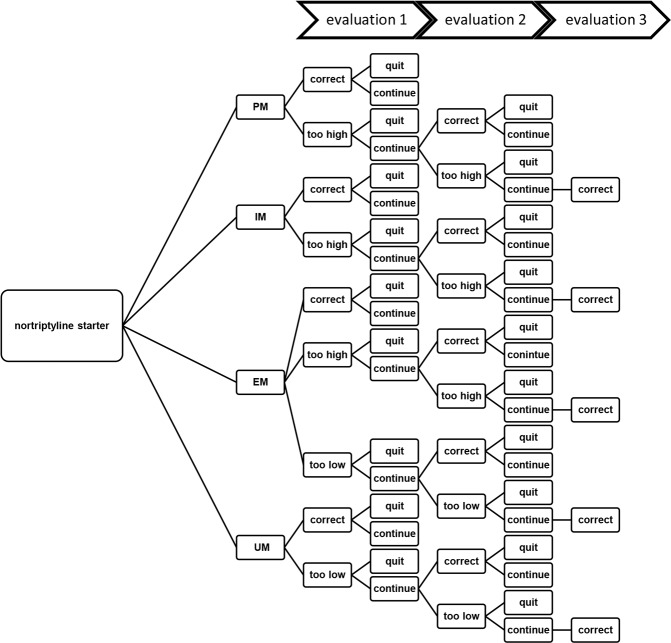
Model structure for the treatment of major depressive disorder with nortriptyline during the first 12 weeks.Patients who receive a dosage which led to therapeutic plasma concentrations (i.e. “correct”) did not receive a next dose evaluation. Patients who quit nortriptyline pharmacotherapy entered a wash out period with a disutility of 0.20 for 14 days. After this period, pharmacotherapy with 6 tranylcypromine was initiated for the remaining time in the model. PM = poor metabolizer, IM = intermediate metabolizer, EM = extensive metabolizer, UM = ultrarapid metabolizer.